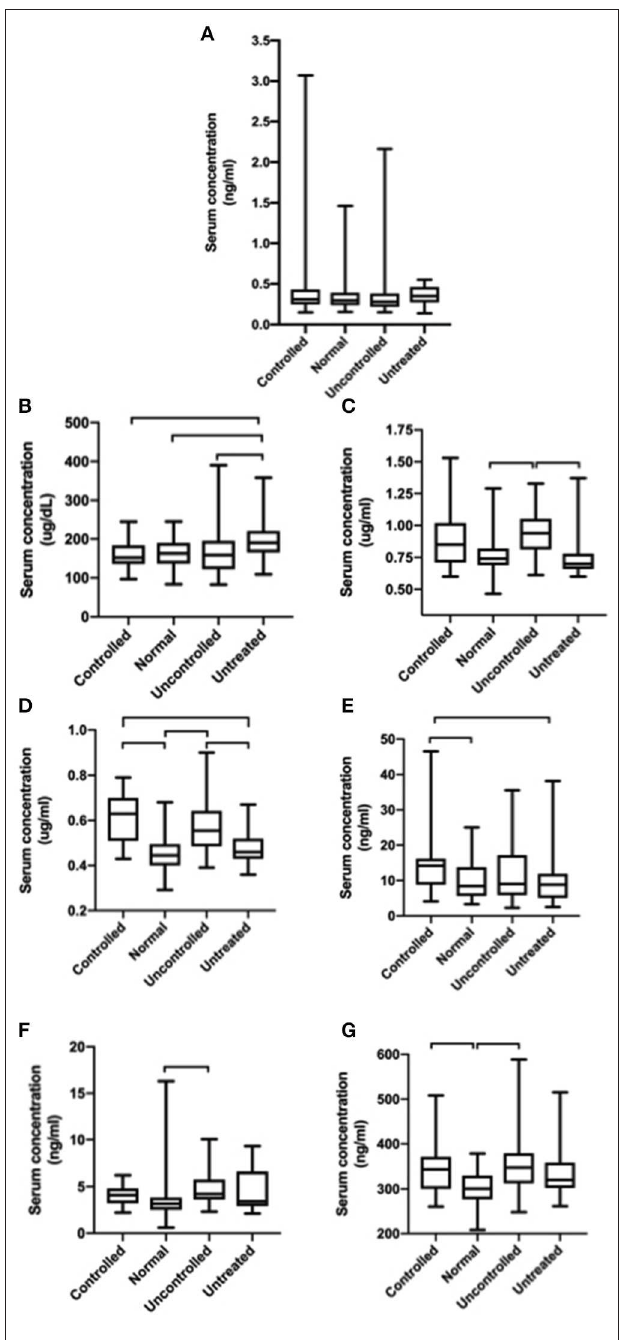
FIGURE 1 | Box and Whisker plots show the distribution of each trace nutrient between epileptic subgroups and normal dogs. Statistically significant differences between groups are highlighted using brackets. (A) Cobalt, (B) Iron, (C) Zinc, (D) Copper, (E) Molybdenum, (F) Manganese, and (G)